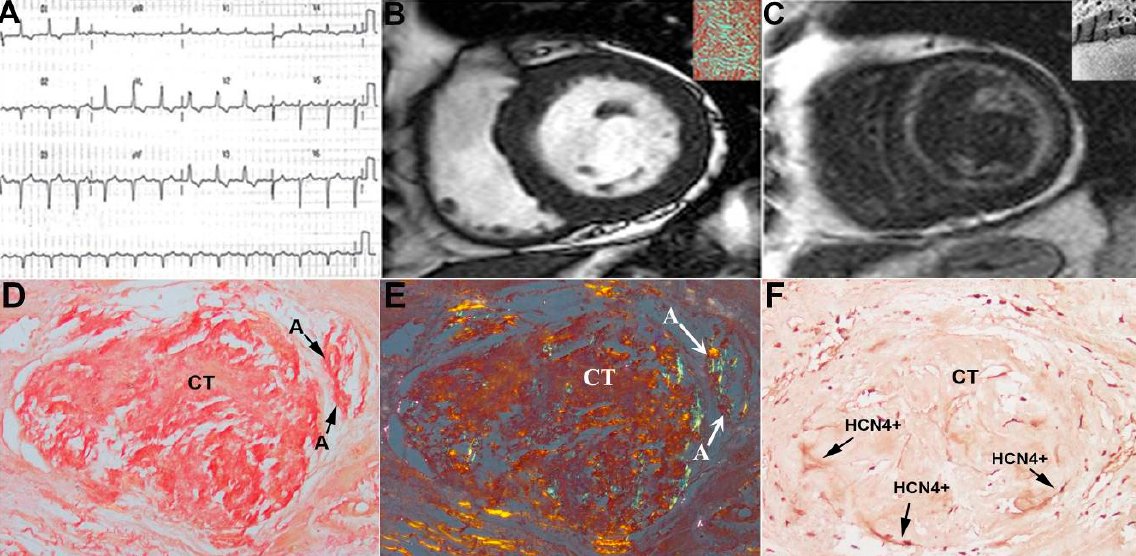
Figure 4. Severe infiltration of CT in cardiac amyloid. Cardiac amyloid presenting with remarkable conduction abnormalities at ECG (right bundle branch block + left anterior fascicular block +I degree A-V block ( panel ( A )) and mildly thickened LV ( panel ( B ), MWT 13 mm) with diffuse “zebroid” LGE at CMR ( panel ( C )). Histology with Congo Red staining ( panel ( D , E ) without and with polarized light) and immunohistochemistry for HCN4 ( panel ( F )) show massive infiltration of CT involving CT artery (a). Apple-green birefringent material at polarized light of Congo Red-stained myocardial sections is visible in insert in panel ( B ). Inserts in panel ( C ) suggest ultrastructural evidence of amyloidosis of the myocardium. A = arteriole CT = conduction tissue Black Arrows indicate the positivity immunohistochemistry for